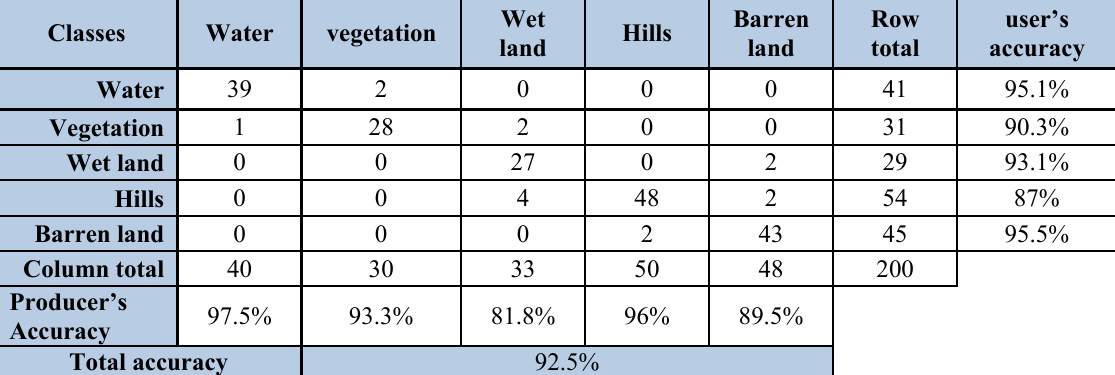
Table 8: Error matrix with producers, users, and overall accuracy calculations for supervised classification using SVD for Landsat-5 (1990).